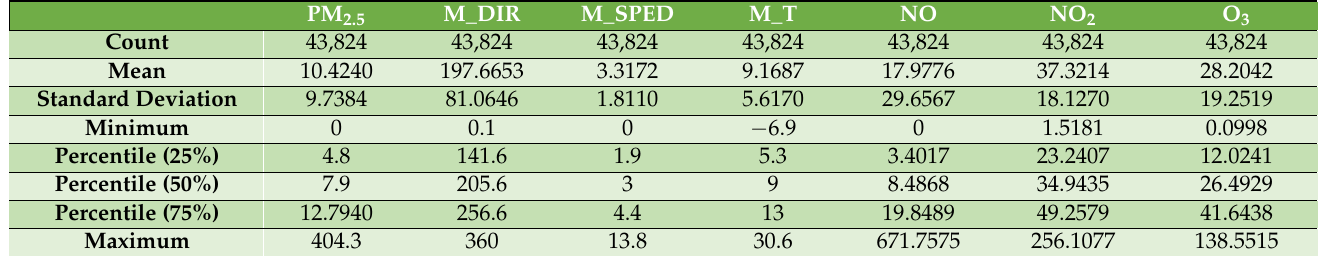
Table 4. Piccadilly station, Manchester, UK dataset statistics after imputation and processing.